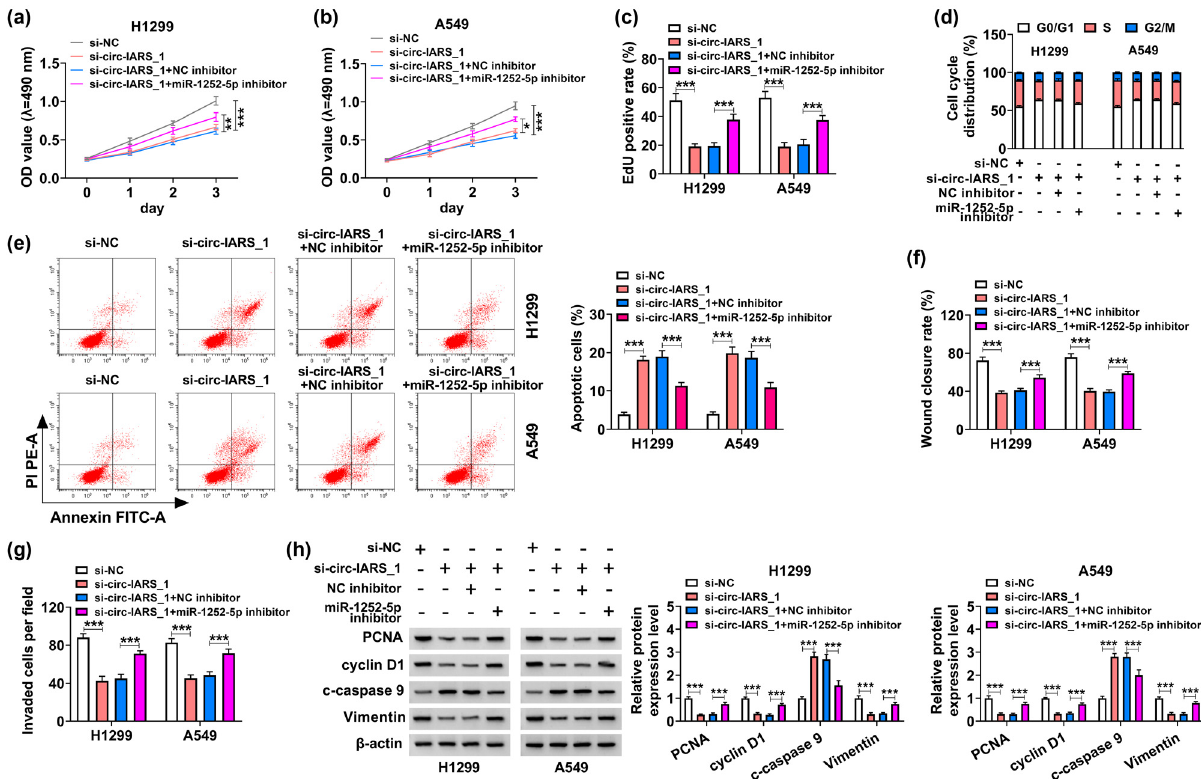
Figure 4: Downregulation of miR - 1252 - 5p counteracted the e ff ects of circ - IARS exhaustion in NSCLC cells. H1299 and A549 cells transfected with si - NC, si - circ - IARS_1, si - circ - IARS_1 + miR - 1252 - 5p inhibitor, or si - circ - IARS_1 + NC inhibitor. ( a and b ) MTT assay monitored the OD value at 490 nm. ( c ) EdU assay determined the EdU - positive rate. ( d ) FCM method analyzed the cell cycle distribution ( % ) in G0/G1, S, and G2/M phases. ( e ) FCM method analyzed the apoptotic cells ( % ) . ( f ) Scratch wound assay measured the wound closure rate. ( g ) Transwell assay examined the invaded cells per fi eld ( 100 ×) . ( h ) Western blotting detected the relative protein expression level of PCNA, cyclin D1, c - caspase 9, and vimentin in transfected cells, normalized to β - actin. * P < 0.05, ** P < 0.01, and *** P <